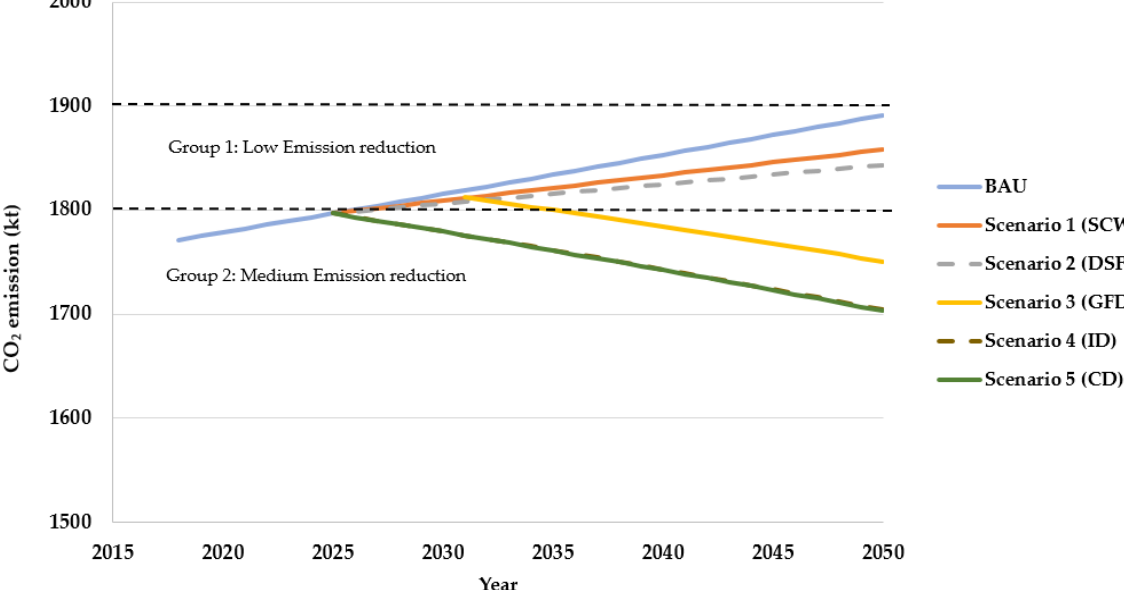
Figure 10. Projection of CO 2 emission by alternative scenarios without DEH (direct electric heating) technology.